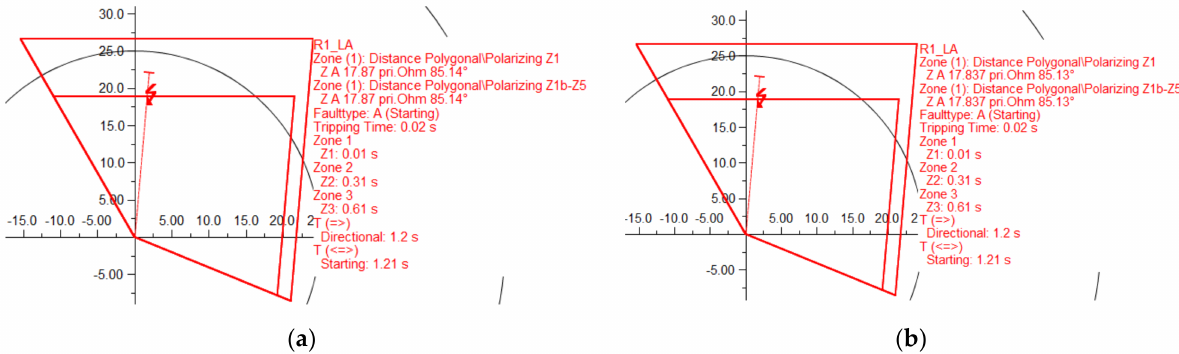
Figure 15. R-X plot for an SLG fault at 80% of line A, with ( a ) both lines connected ( b ) line B